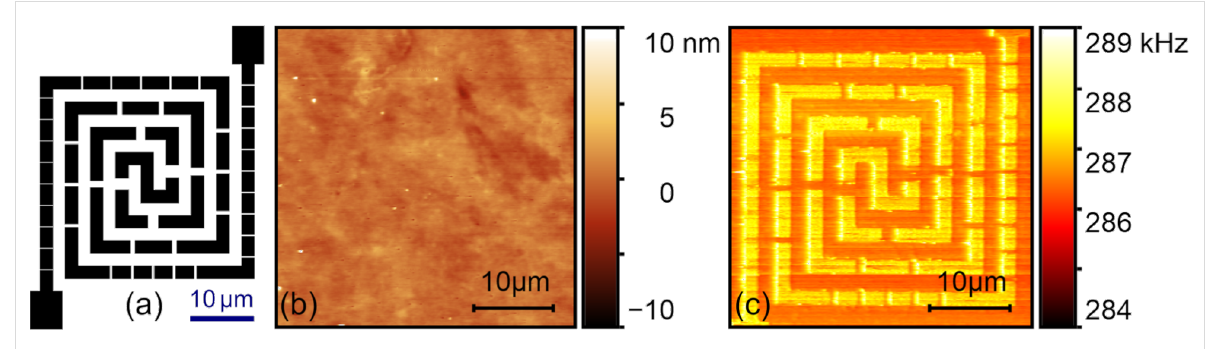
Figure 9: Subsurface imaging of defects in the buried circuit pattern using CR-AFM. (a) Schematic illustration of the introduced defects in the middle layer pattern. (b) Topography. (c) The first mode resonance frequency of a sample with a top layer thickness of 358 nm. A PPP-FM probe was used with an applied normal force of 1162 nN.